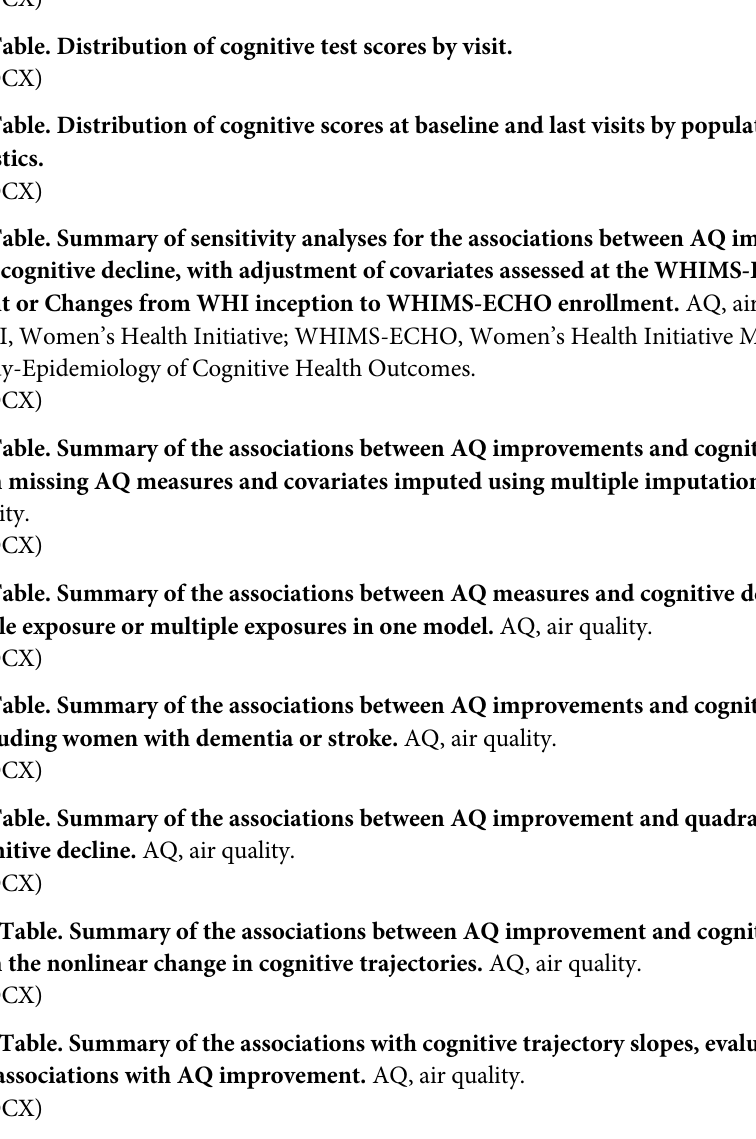
S1 Fig. Map of US with region, state, and clinic sites of WHIMS participants. The direct link to the base layer of the map used in this figure: https://services.arcgis.com/ P3ePLMYs2RVChkJx/arcgis/rest/services/USA_States_Generalized/FeatureServer. Maps were created using ArcGIS software by Esri. ArcGIS and ArcMap are the intellectual property of Esri and are used herein under license. Copyright Esri. All rights reserved. For more informa- tion about Esri software, please visit www.esri.com. WHIMS, Women’s Health Initiative Memory Study. S1 Table. Comparing study samples with repeated CVLT measures versus excluded due to no repeated CVLT measures. CVLT, California Verbal Learning Test. S2 Table. Pearson correlations between AQ measures. AQ, air quality. S3 Table. Distribution of cognitive test scores by visit. S4 Table. Distribution of cognitive scores at baseline and last visits by population charac- teristics. S5 Table. Summary of sensitivity analyses for the associations between AQ improvements and cognitive decline, with adjustment of covariates assessed at the WHIMS-ECHO enroll- ment or Changes from WHI inception to WHIMS-ECHO enrollment. AQ, air quality; WHI, Women’s Health Initiative; WHIMS-ECHO, Women’s Health Initiative Memory